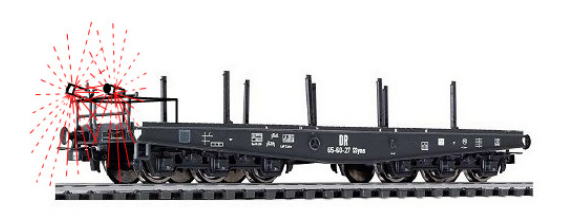
Figure 2. Schematic diagram of flatcar with two diagonal scanners